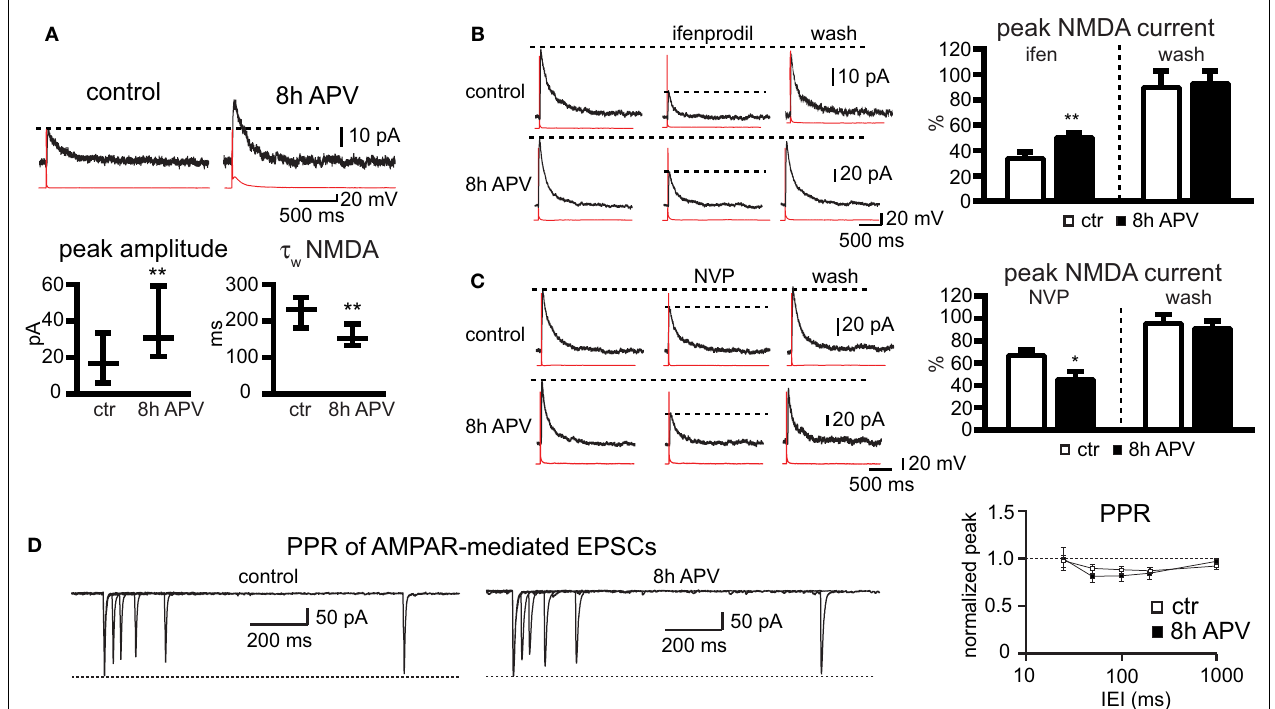
FIGURE 6 | APV treatment increases synaptic NMDAR-mediated EPSCs in and after washout of the NR2B-selective blocker. The quantifi cation shows the cultured cells. (A) Paired recordings were performed in primary hippocampal decrease in ifenprodil sensitivity in cells treated for 8 h with APV compared to cultures. APs (red) were evoked in a presynaptic cell, and NMDAR-mediated control cells (mean ± SEM). (C) Example traces of NMDAR-mediated currents EPSCs (black) were recorded in a postsynaptic cell at a holding potential of without and with NVP and after washout of the NR2A-preferring blocker. The + 40 mV. Cultures were treated either for 30 min with APV (control) or for 8 h quantifi cation shows the increase in NVP sensitivity in cells treated for 8 h with with APV before recording. 8 h-APV increased the peak amplitude of NMDAR- APV compared to control cells (mean ± SEM). (D) 8 h of APV treatment did not mediated EPSCs and decreased the τ of the EPSC deactivation (median ± IQR). change the PPR of AMPAR-mediated EPSCS. EPSCs were evoked with IEI of w (B) Example traces of NMDAR-mediated currents without and with ifenprodil 25, 50, 100, 200, and 1000 ms (mean ±